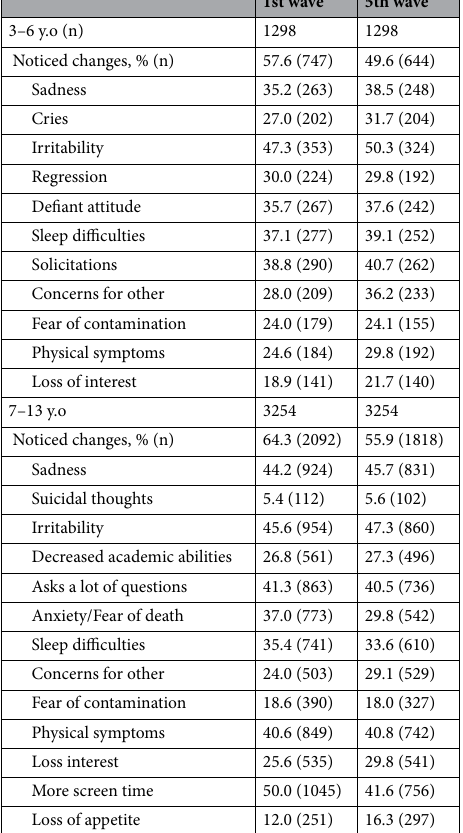
Table 1. Emotional and behavioral changes along the pandemic during the 1st and the 5th